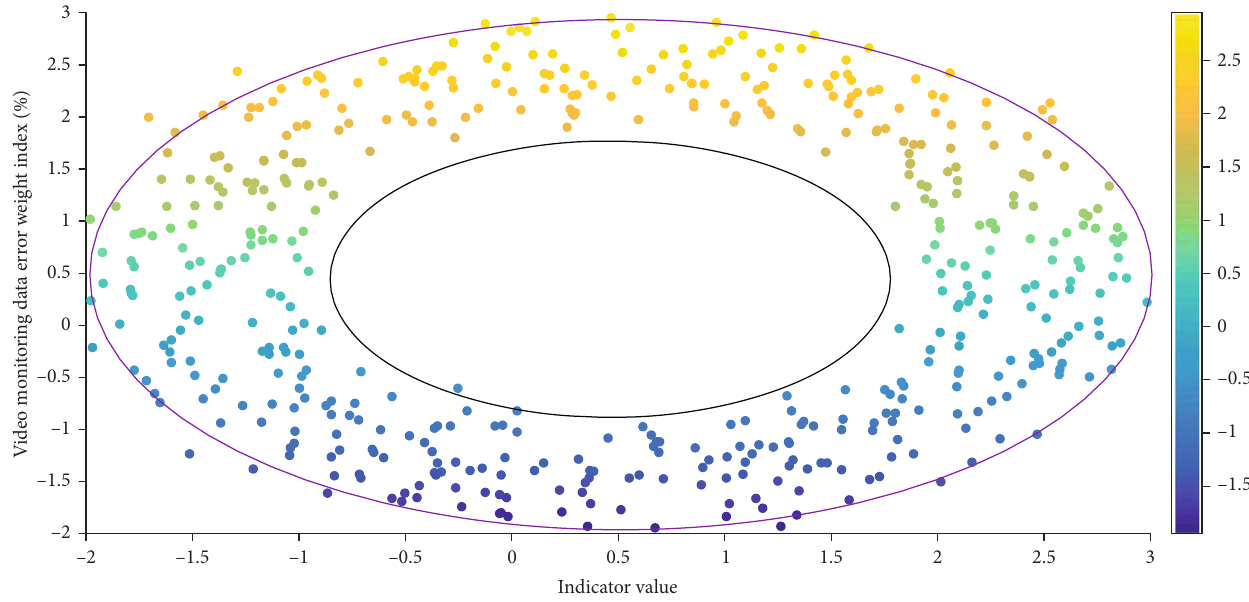
Figure 5: Error fi tting distribution of video monitoring